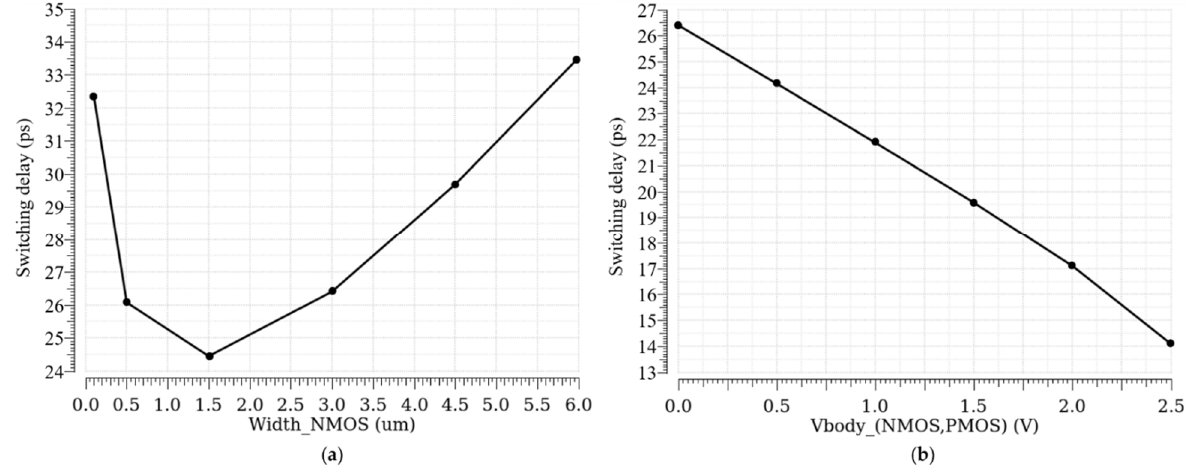
Figure 3. Switching delay of an inverter versus: ( a ) NMOS width; ( b ) body voltage of the NMOS and the PMOS.